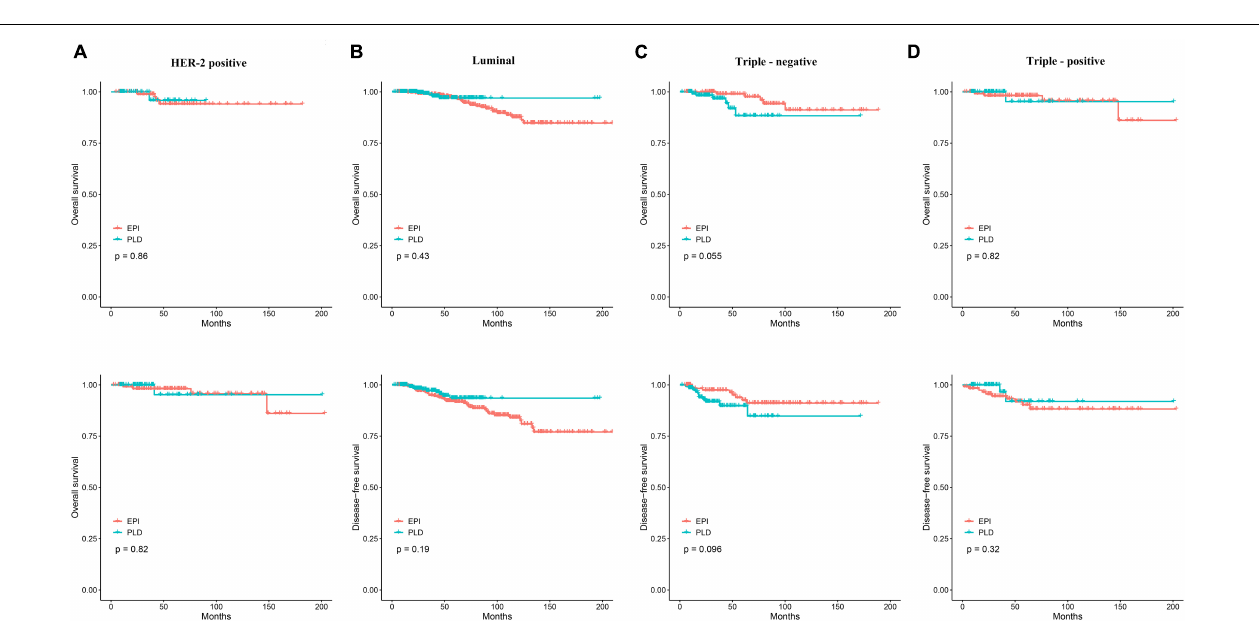
FIGURE 3 | (A) The Kaplan–Meier curves comparing OS and DFS between the two groups in the HER2-positive patients. (B) The Kaplan–Meier curves comparing OS and DFS between the two groups in the luminal patients. (C) The Kaplan–Meier curves comparing OS and DFS between the two groups in the triple-negative patients. (D) The Kaplan–Meier curves comparing OS and DFS between the two groups in the triple-positive patients. OS, overall survival; DFS, disease-free